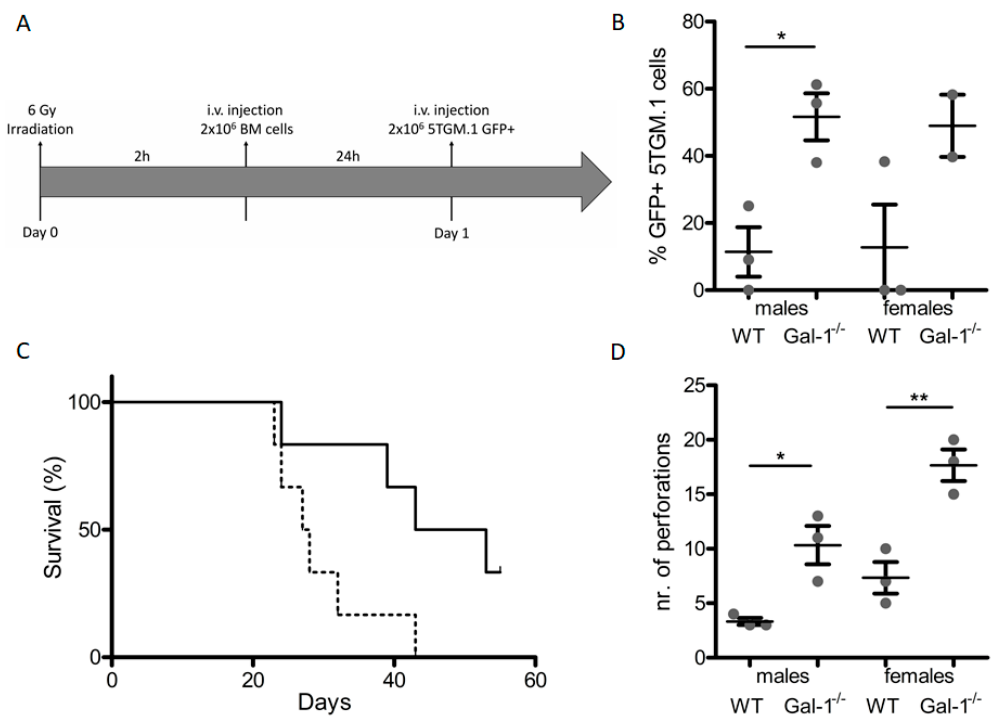
Figure 4. Loss of stromal gal-1 enhances myeloma growth . ( A ) MM C57BL/6 WT and gal-1 − / − model. Mice were irradiated at 6Gy and subsequently received syngeneic bone marrow (BM) cells. MM cells (5TGM.1 GFP+) were injected 24 h post-transplantation. ( B ) Percentage of 5TGM.1 GFP+ bone marrow infiltration. ( C ) Survival curve (solid line: wild-type; dotted line: gal-1 − / − ). ( D ) Bone µCT analysis of WT and gal-1 − / − MM-bearing mice, showing the number of cortical perforations. Data shown are the mean +/ − standard error of three mice and are representative of three biologically independent experiments. * p < 0.05; ** p < 0.01.